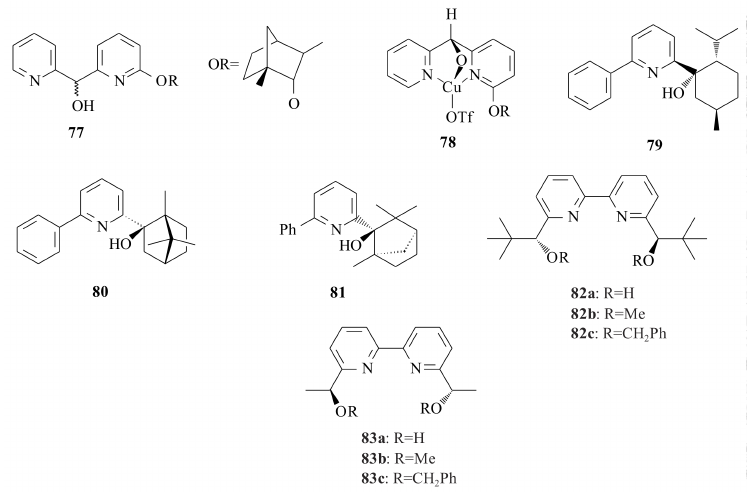
Figure 15. Ligands and typical Cu complex used for